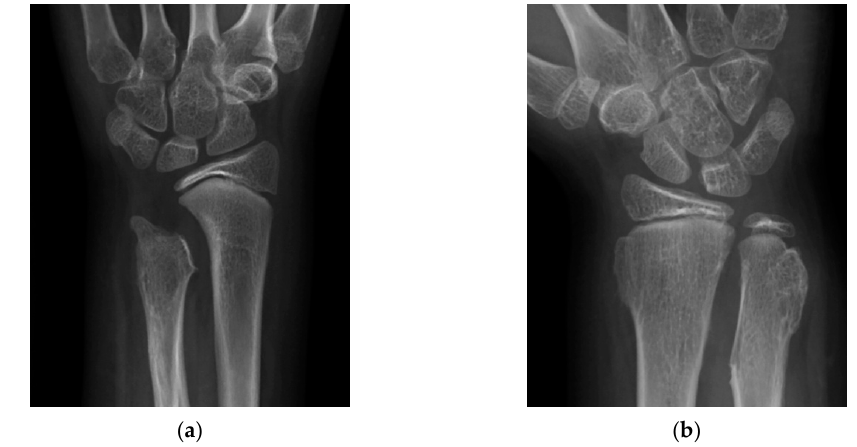
Figure 5. Radiographs of ( a ) a 10-year-old girl who underwent ulnar lengthening with recurrence two years later showed loss of the discoid nature of the distal ulnar physis; ( b ) a 9-year-old boy following ulnar lengthening at the age of three without recurrence showed smooth discoid nature of distal ulnar physis.